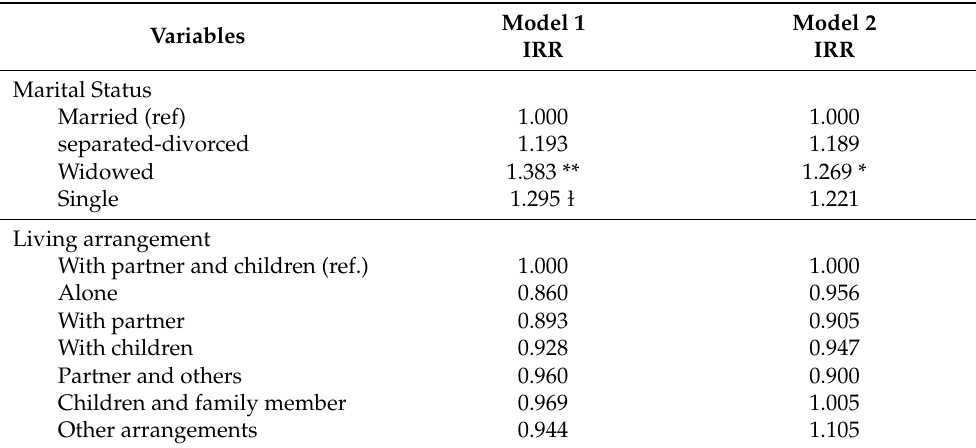
Table 4. Rate ratios for the association between marital status, living arrangements and mortality in older adults,